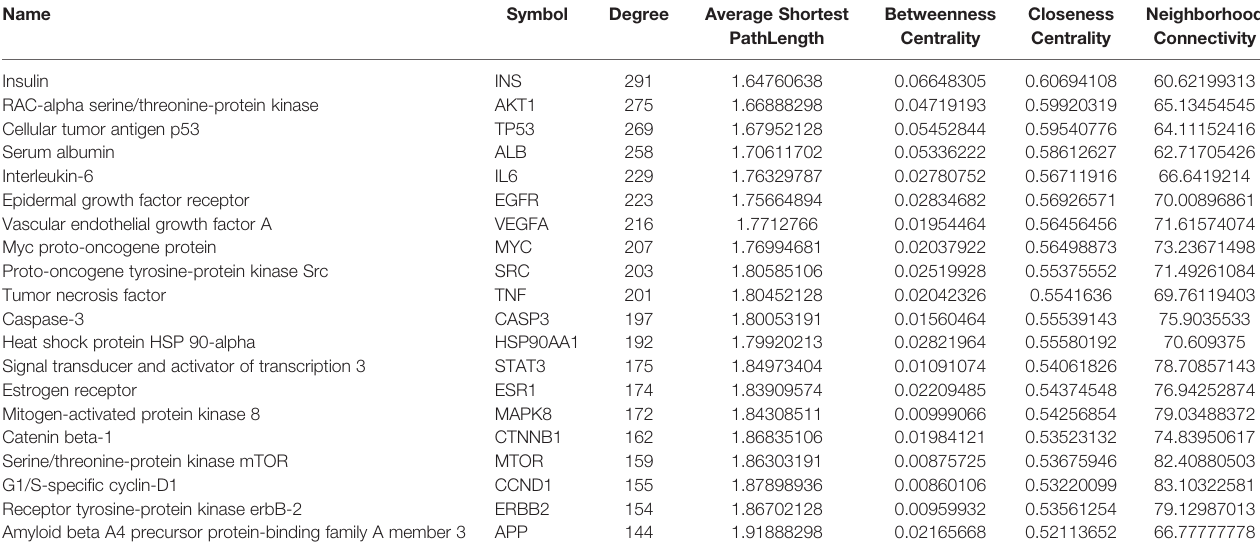
TABLE 2 | Degree of core regulatory genes analyzed by Cytoscape.